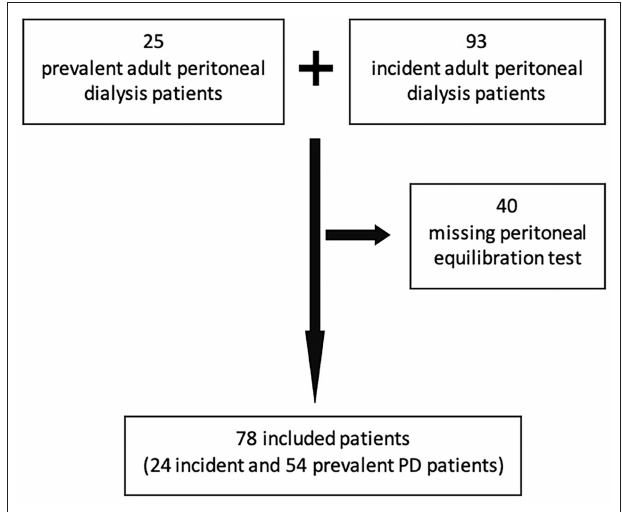
FIGURE 1 | Strobe diagram showing the total number of PD patients assessed for inclusion and included in the